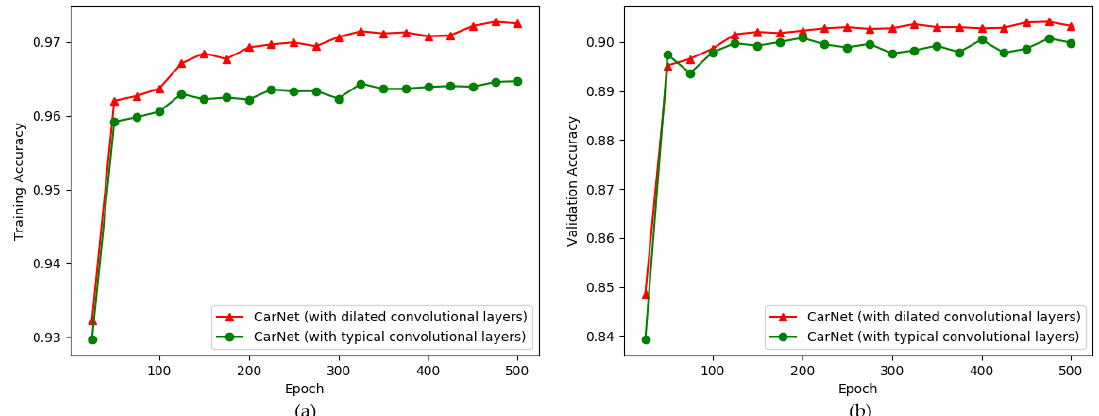
Figure 9. Comparison of CarNet (with dilated convolutional layers) and CarNet (with normal convolutional layers). x-direction: number of epochs (500), y-direction: accuracy. ( a ) training accuracy; ( b ) validation accuracy.